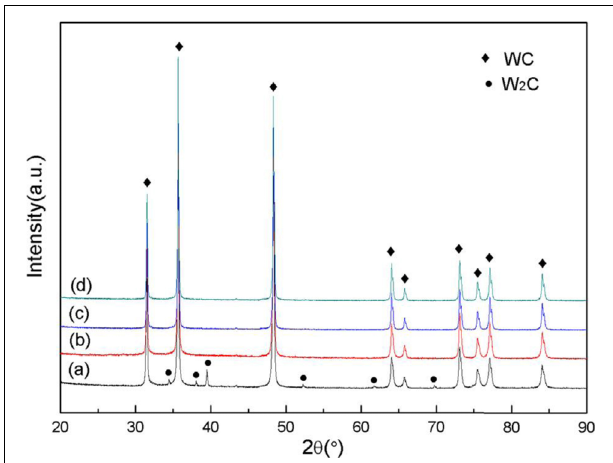
FIGURE 11 | XRD patterns of: (a) W powder at 1300 ◦ C; (b) W-As powder at 1300 ◦ C; (c) W powder at 1400 ◦ C; (d) W-As powder at 1400 ◦ C (Wang et al., 2018) [Figure 3 of Wang et al. (2018), Copyright Elsevier B.V. and The Society of Powder Technology Japan].